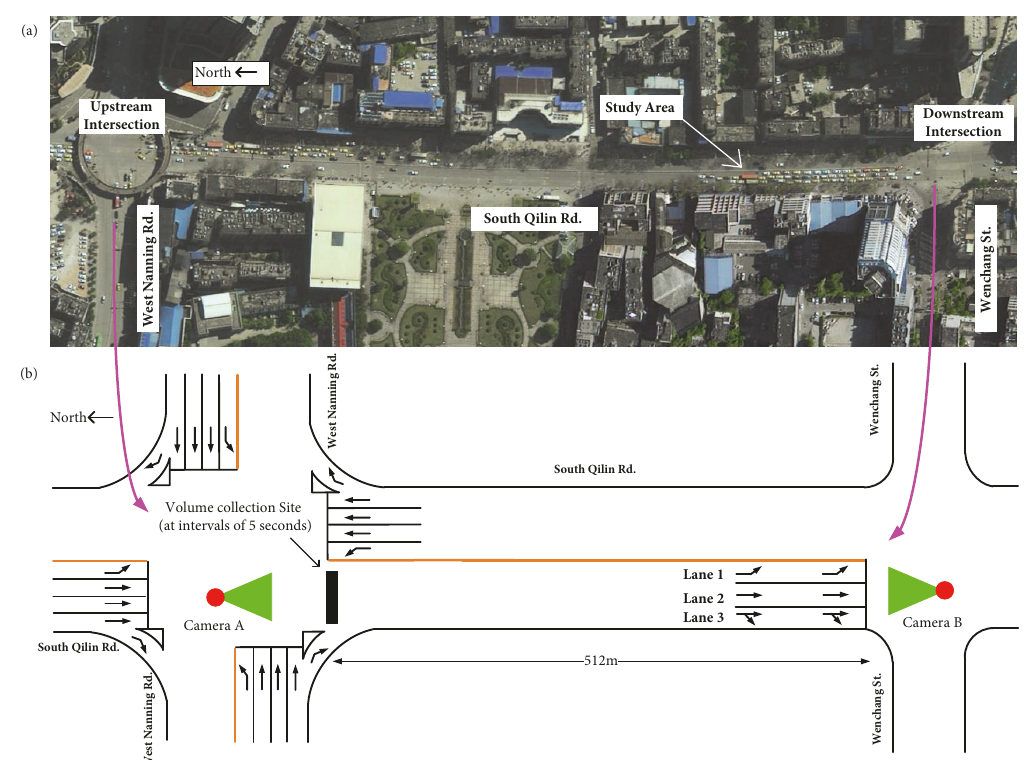
Figure 6: (a) Aerial photograph of the study area; (b) data collection